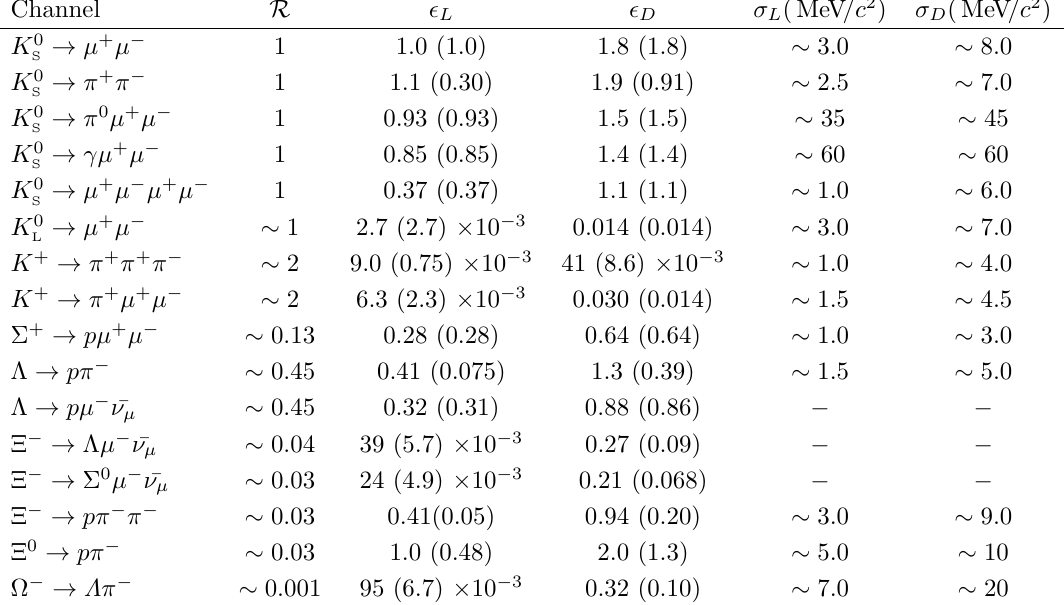
Table 1 . Acceptance scale factors (cid:15) , and mass resolutions (cid:27) , for only long ( L ) and only down- stream ( D ) tracks obtained from our simpli(cid:12)ed description of the LHCb Upgrade tracking system geometry. The production ratio of the strange hadron with respect to K 0 e(cid:14)ciencies are normalised to that of fully reconstructed K 0 and anti-particles. Channels containing a photon, neutrino and (cid:25) 0 are partially reconstructed.